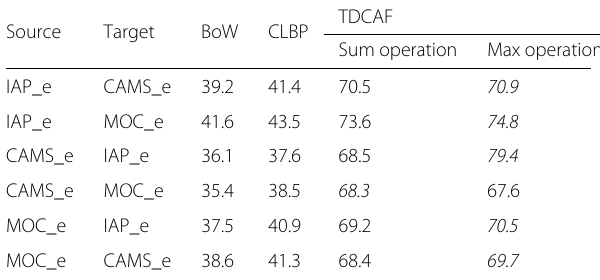
Table 3 Classification accuracies (%) for the ground-based cloud classification